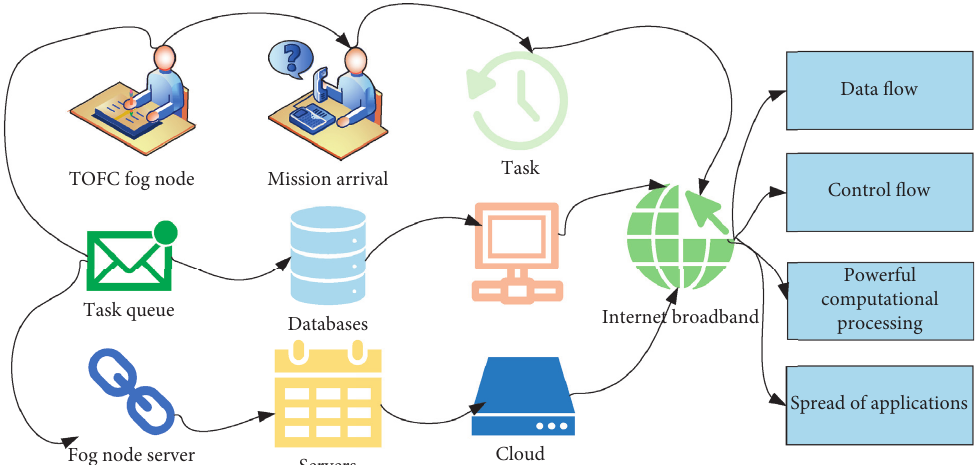
Figure 1: Schematic diagram of the task processing process